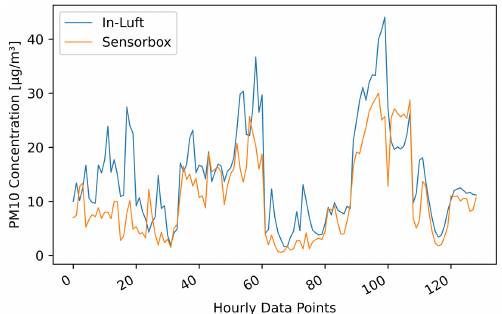
Figure 17. PM 10 hourly mean data recorded with mobile pilot sensor-box 6 located in Ebikon in the period from 15 October 2021 to 15 November 2021 compared to hourly mean data recorded at the in-luft station located in Ebikon, Sedel. Data gaps are removed from graph. Data recorded within a radius of 150 m around the maintenance depot Ebikon are removed. Number of mean hourly values: N = 129; Resulting correlations: R P = 0.81, R S = 0.83.